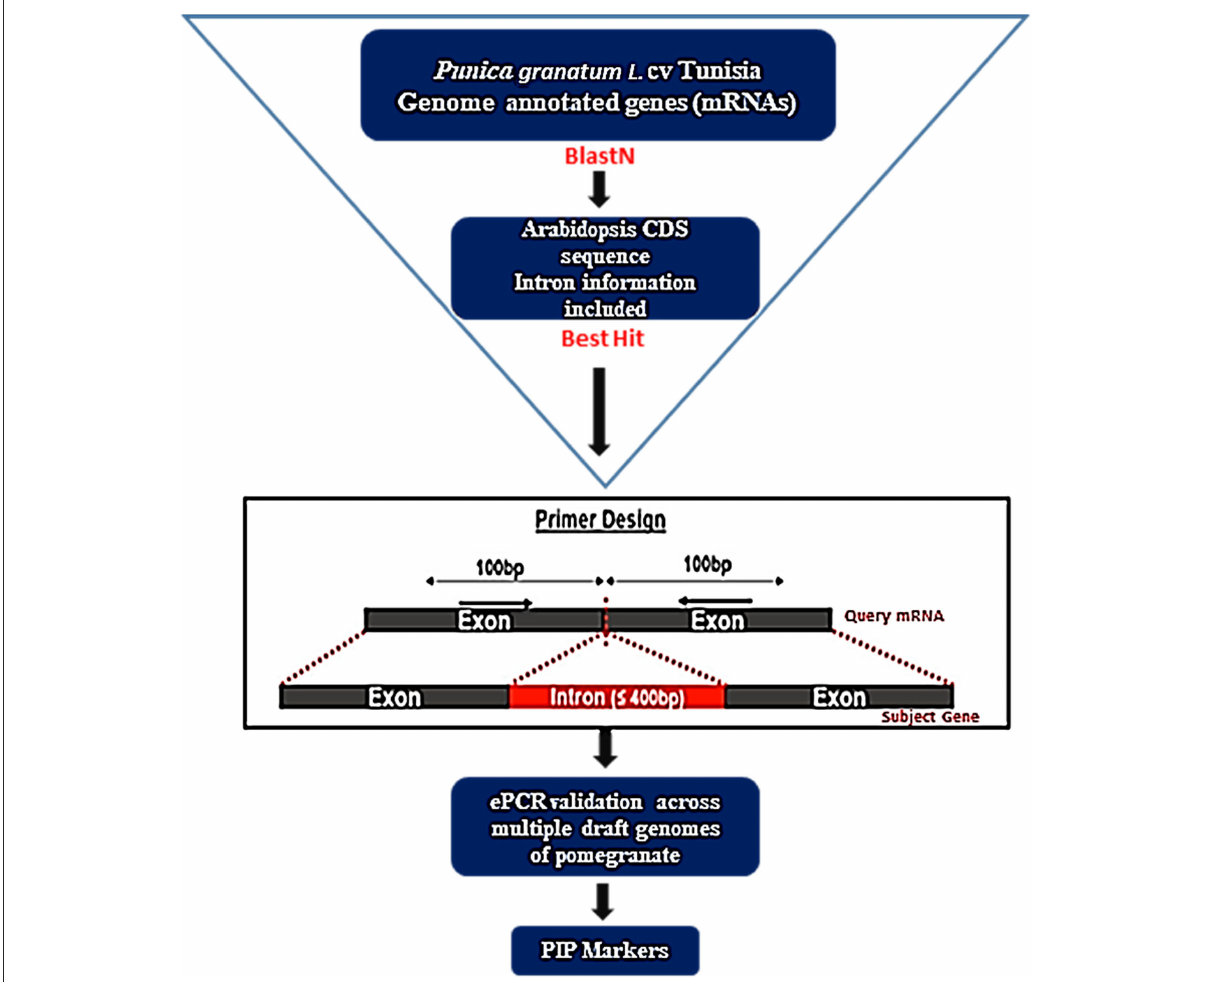
FIGURE1 A flowchart depicting the development of PIP marker in pomegranate using the PIP database (Image source: http://ibi.zju.edu.cn/pgl/pip/